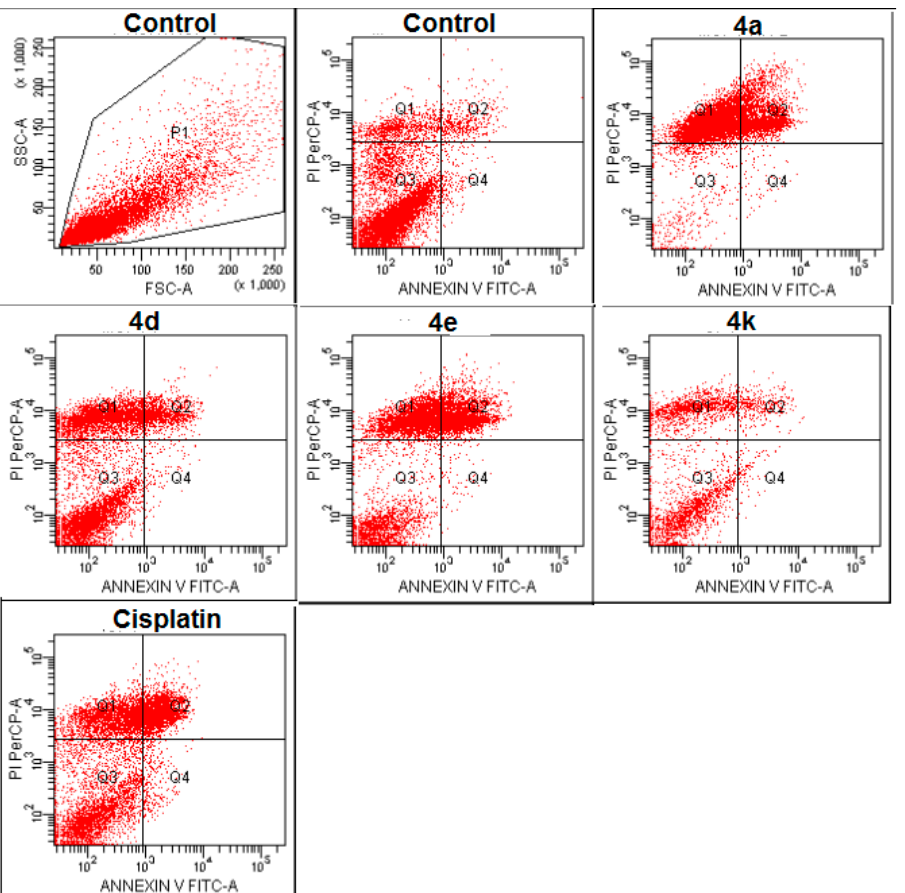
Figure 5. Flow cytometric diagrams of MCF-7 cells treated with compounds 4a , 4d , 4e , 4k , and cisplatin.